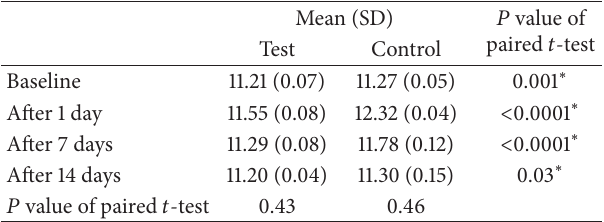
Table 3: Comparison of swellings between test and control at different follow-up periods (in